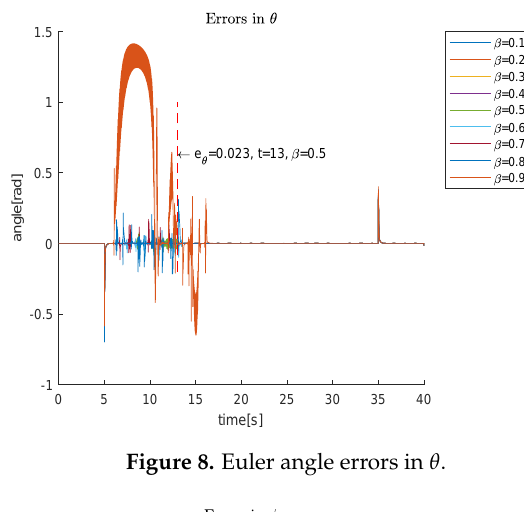
Figure 7. Euler angle errors in φ .